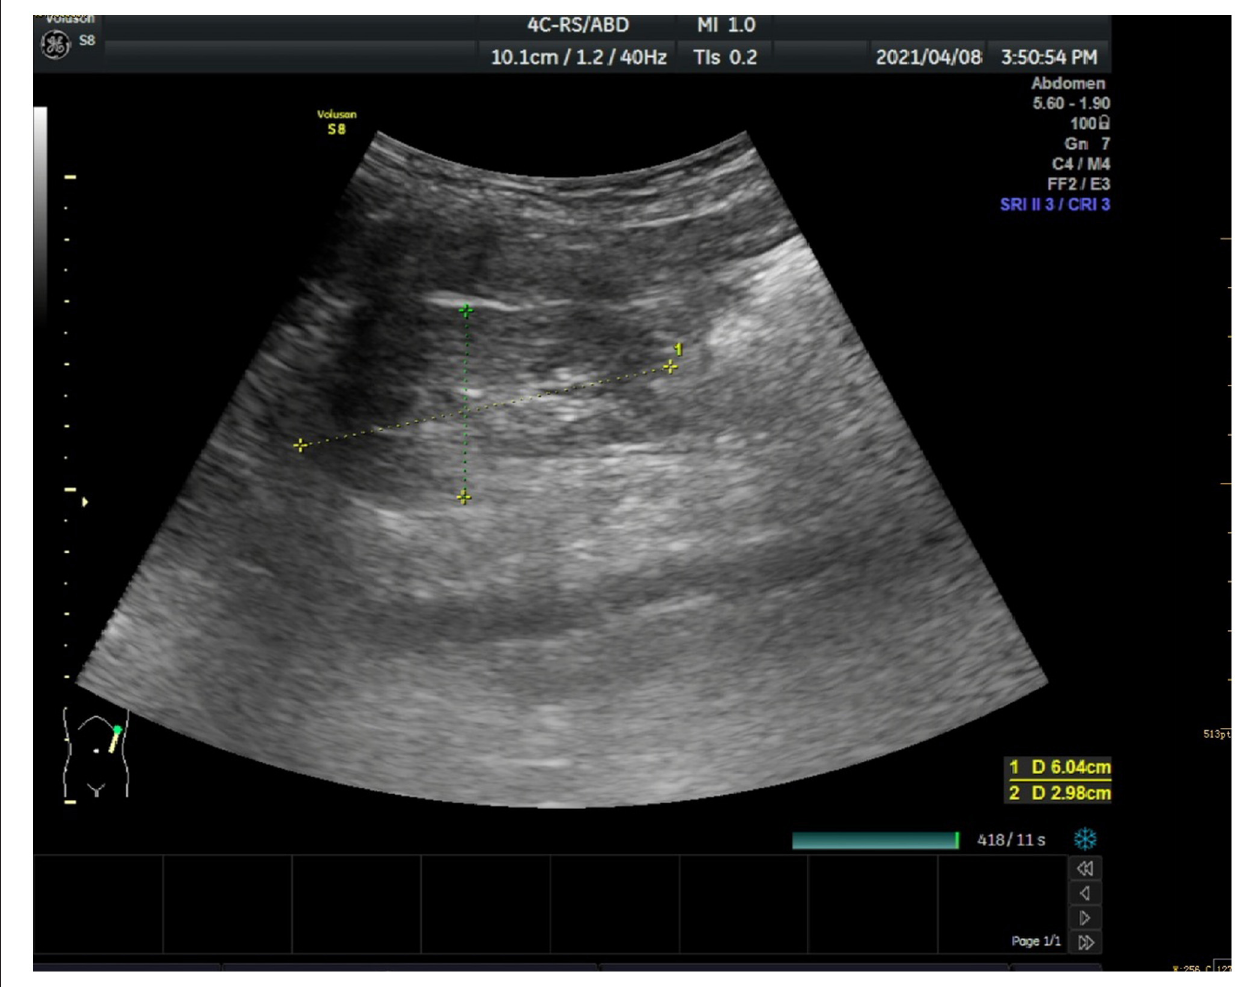
FIGURE 1 | Renal ultrasound image.